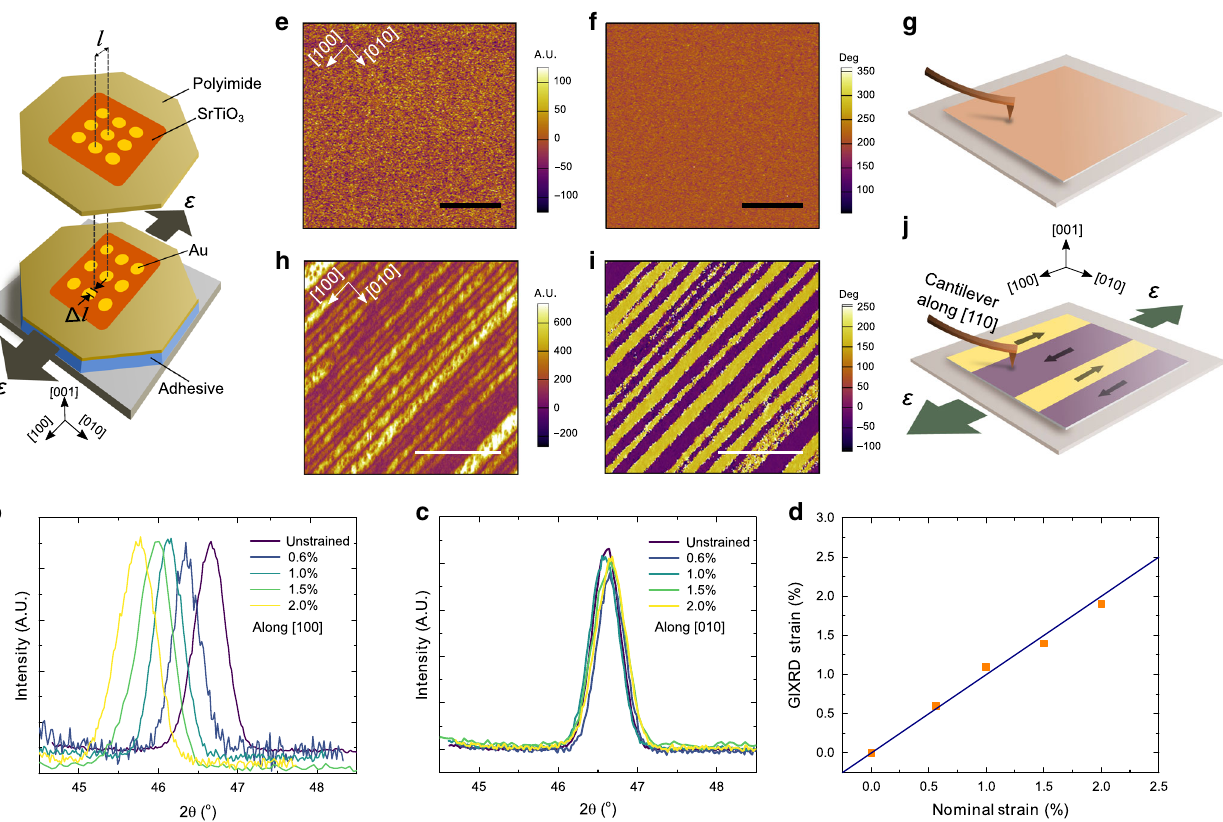
Fig. 2 Characterization of room-temperature ferroelectricity in strained SrTiO 3 membranes. a Schematic illustrating the strain apparatus, wherein the SrTiO 3 membrane and polyimide sheet are stretched and fi xed to a rigid substrate to maintain their strain state, with the ordered array of gold markers used for strain calibration. Grazing incidence X-ray diffraction (GIXRD) results measured along b [100] strain direction and c [010] direction which was fi xed to the unstrained state. d Comparison of GIXRD strain and the optically measured nominal strain. Error bars within the size of the marker represent the standard deviation. Piezoresponse force microscopy (PFM) amplitude e and phase f measured from unstrained membranes exhibit weak piezoresponse, indicating the absence of room-temperature ferroelectricity, illustrated in schematic g . PFM amplitude h and phase i measured from 2.0% uniaxially strained membranes exhibit room-temperature ferroelectricity with the notable 180° domain structure, illustrated in schematic j . The scale bar is 1 µ calculated the energy of the paraelectric and ferroelectric phase in SrTiO 3 as a function of strain using DFT calculations with a 5- atom unit cell and local density approximation (LDA) (see “ Methods ” and Fig. 4a). DFT calculations reveal that the ferro- energy difference when the applied strain is >0.25%. Also, con-